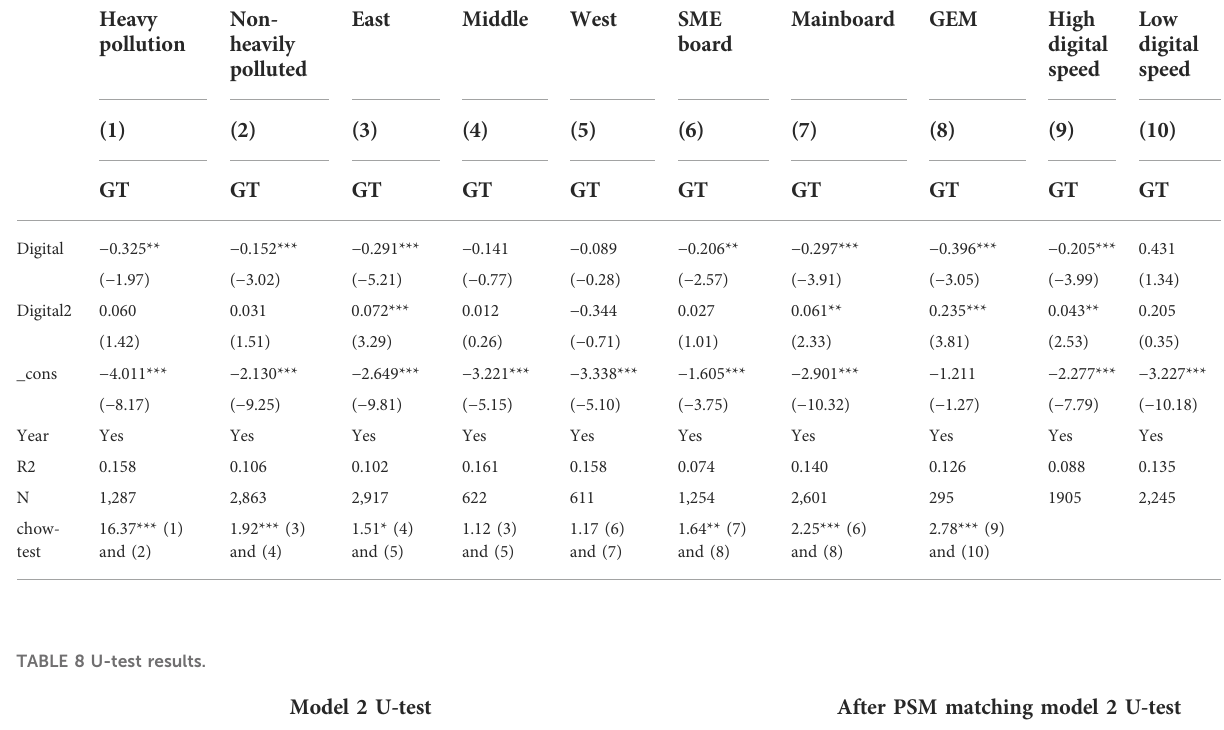
TABLE 7 Heterogeneity test after PSM.